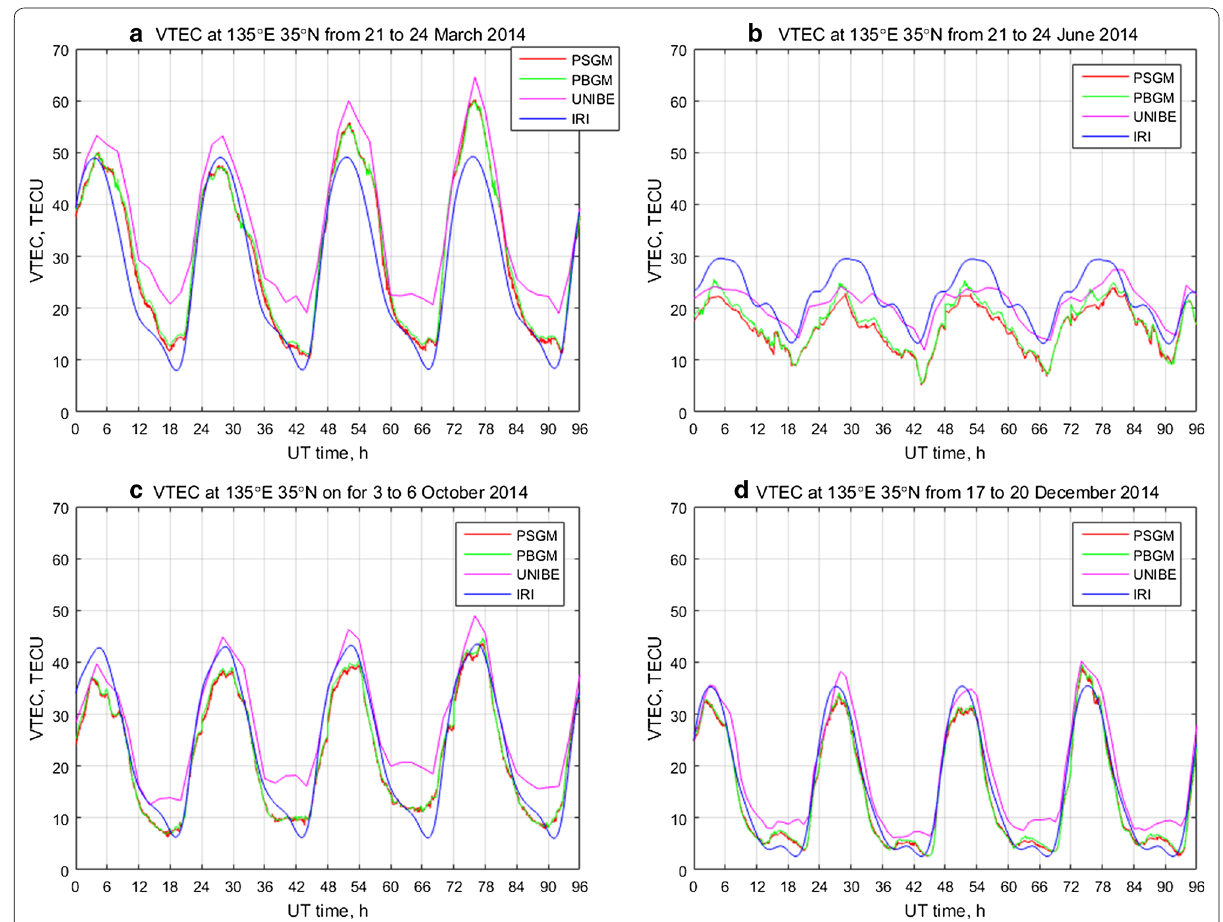
Fig. 1 VTEC diurnal variation of 2014 at 135°E 35°N. a 21–24 March; b 21–24 June; c 3–6 October; d 17–20 December